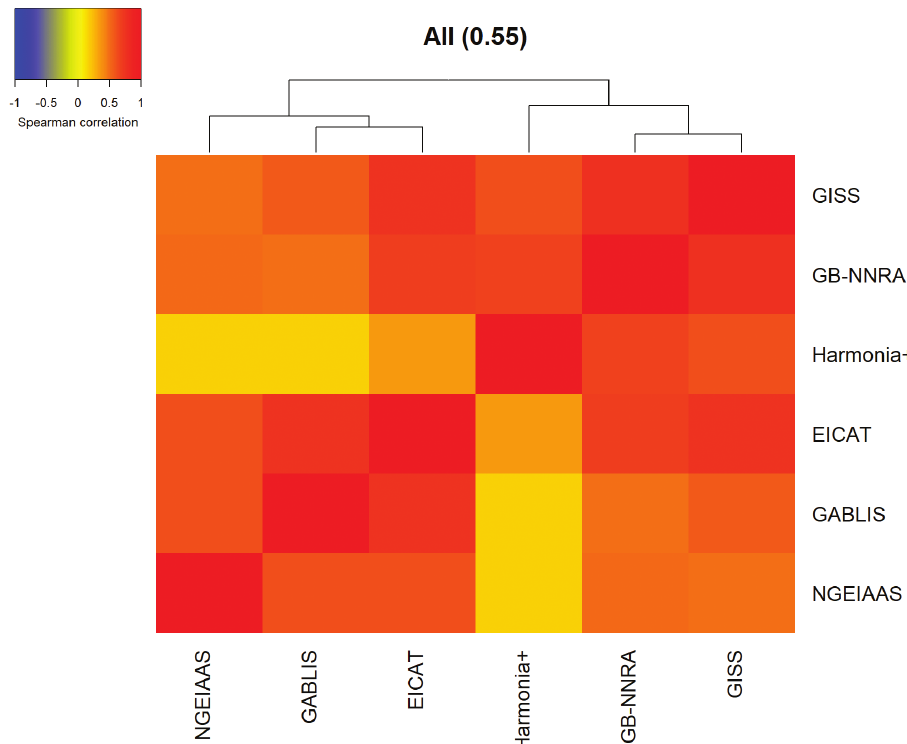
Figure 3. Spearman correlation matrix and hierarchical cluster of species scorings for the protocols com- mon for all species. The color scale indicates the correlation between the species scorings obtained for each protocol pair. In brackets, the mean of all pair-wise